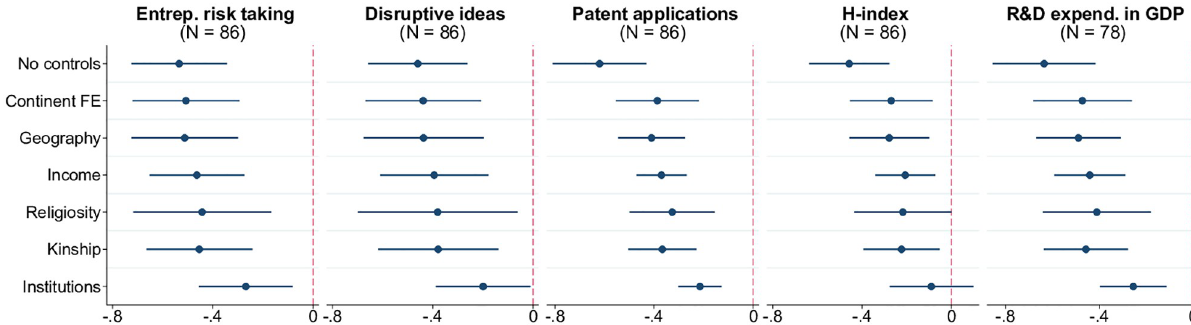
Fig 7. Witchcraft beliefs and innovation. Each panel of the figure presents the results of estimating 7 different models, in which the metric of innovation indicated in the panel title is regressed on the prevalence of witchcraft beliefs, along with a set of control variables. The latter is defined as follows according to the tickmarks on the vertical axis: 1) none for “No controls”, 2) only continental fixed effects for “Continent FE”, 3) continental fixed effects and baseline geographic controls (absolute latitude, terrain ruggedness, agricultural suitability of land, distance to the coastline) for “Geography.” The remaining 4 models, named “Income,” “Religiosity,” “Kinship,” and “Institutions” include, respectively, real GDP per capita, average religiosity, kinship intensity index, and the rule-of-law index (in addition to continental fixed effects and geographic variables). The round marker represents the point estimate for the coefficient on the prevalence of witchcraft beliefs, and the linear segment around each marker is the respective 95% confidence interval based on heteroskedasticity-robust standard errors. Sample size N indicated in parentheses. The key variables are standardized to have zero mean and unit standard deviation in relevant